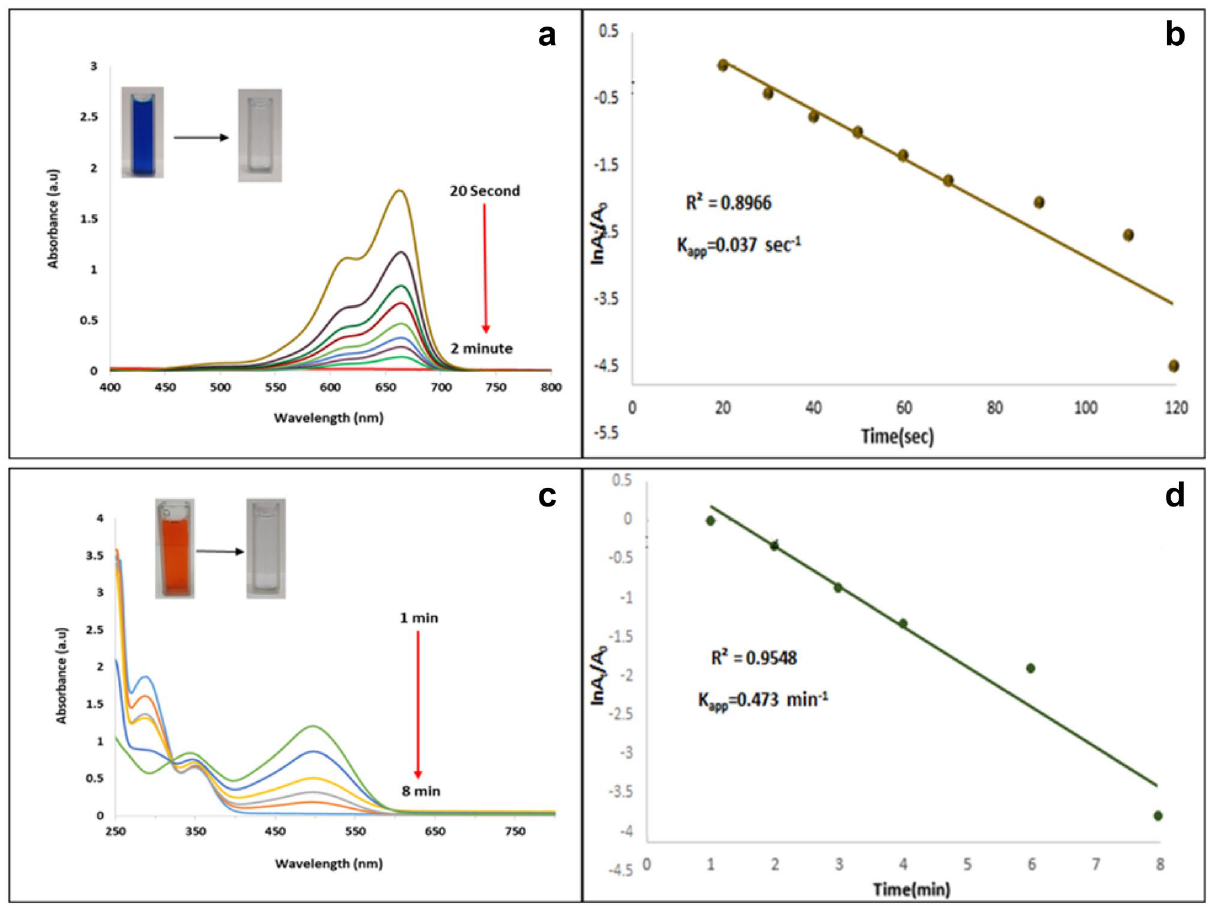
Figure 5. Reduction reaction of MB ( a ) and CR ( c ) by NaBH 4 (10 mmol) and n-HA/Si-PA-SC@Ag (300 mg) in H 2 O at room temperature and plot of ln (A t /A 0 ) against time for the reduction of MB dye ( b ) and CR dye ( d